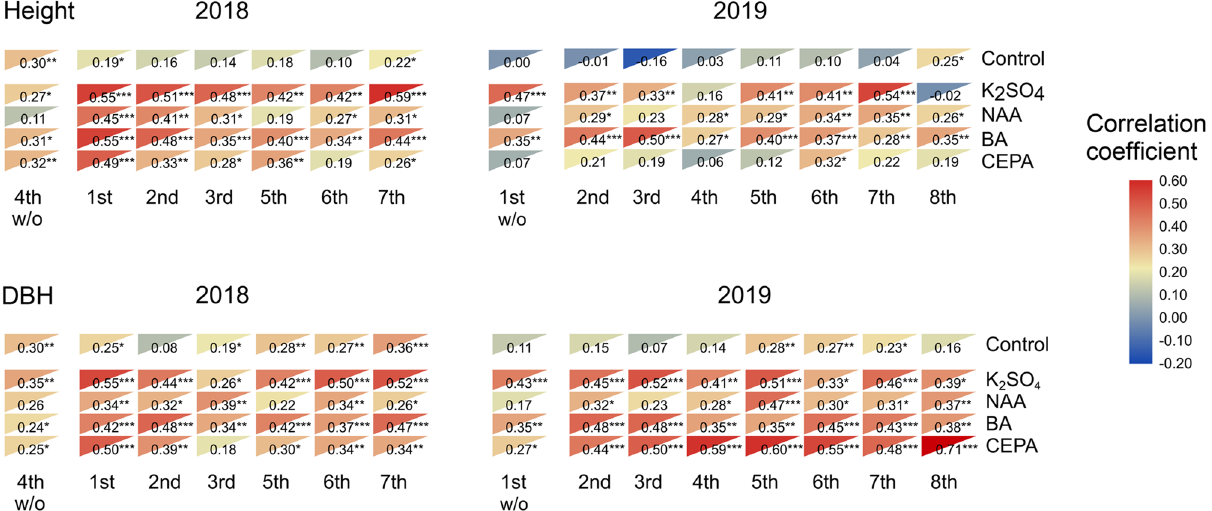
Figure 2. Correlation coefficient between resin yield and height or DBH. The number in the triangle is the correlation coefficient between corresponding resin yield and height or resin yield and DBH. The 4th tapping of 2018 and the 1st of 2019 were performed without (w/o) any resin-stimulating pastes. Asterisks represent the significance of the correlation coefficient. *P < 0.05, **P < 0.01, ***P < 0.001. DBH diameter at breast height, Control tapping without applying resin-stimulating